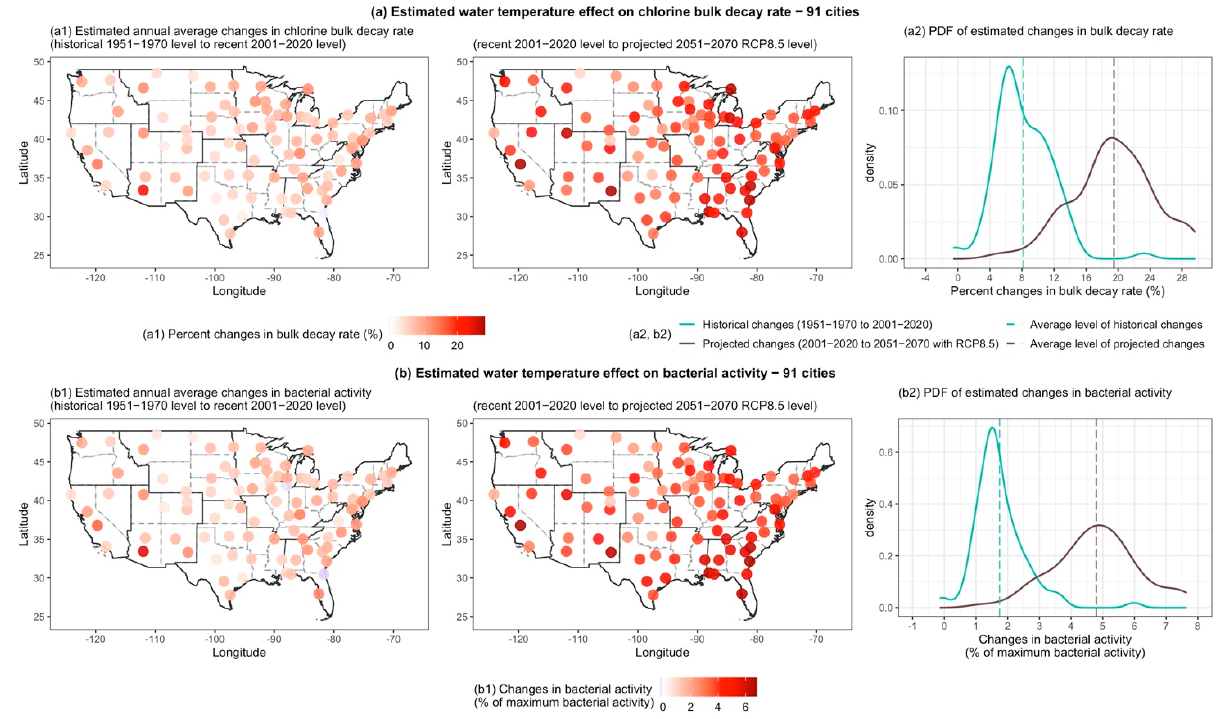
Figure 7. The estimated changes in ( a ) the chlorine bulk decay rate and ( b ) bacterial activity in DWDS for the 91 cities as a result of interannual water (or ambient air) temperature changes. The changes from the 1951–1970 level to the 2001–2020 level and from the 2001–2020 level to the projected 2051–2070 level (under RCP8.5) are presented. The percent changes in the chlorine bulk decay rate were calculated and are presented in part ( a ), while the results of the bacterial activity changes in part ( b ) are presented as absolute differences in percentages of maximum activity (similar to the differences in y-axis between two lines presented in plot Figure 6(c1)). Similar to part c of Figure 6, part b assumes no chlorine present or a chlorine level below the threshold concentration of suppressing bacterial activity. Solid lines around the boundaries of states in part ( a1 ) and ( b1 ) show the nine NOAA climate regions [73]. Similar to Figure 4, the results are directly based on the calculation of historical and projected air temperature and the interpretation of results for particular cities is subject to uncertainty. Further details are offered in Supplemental Material Section